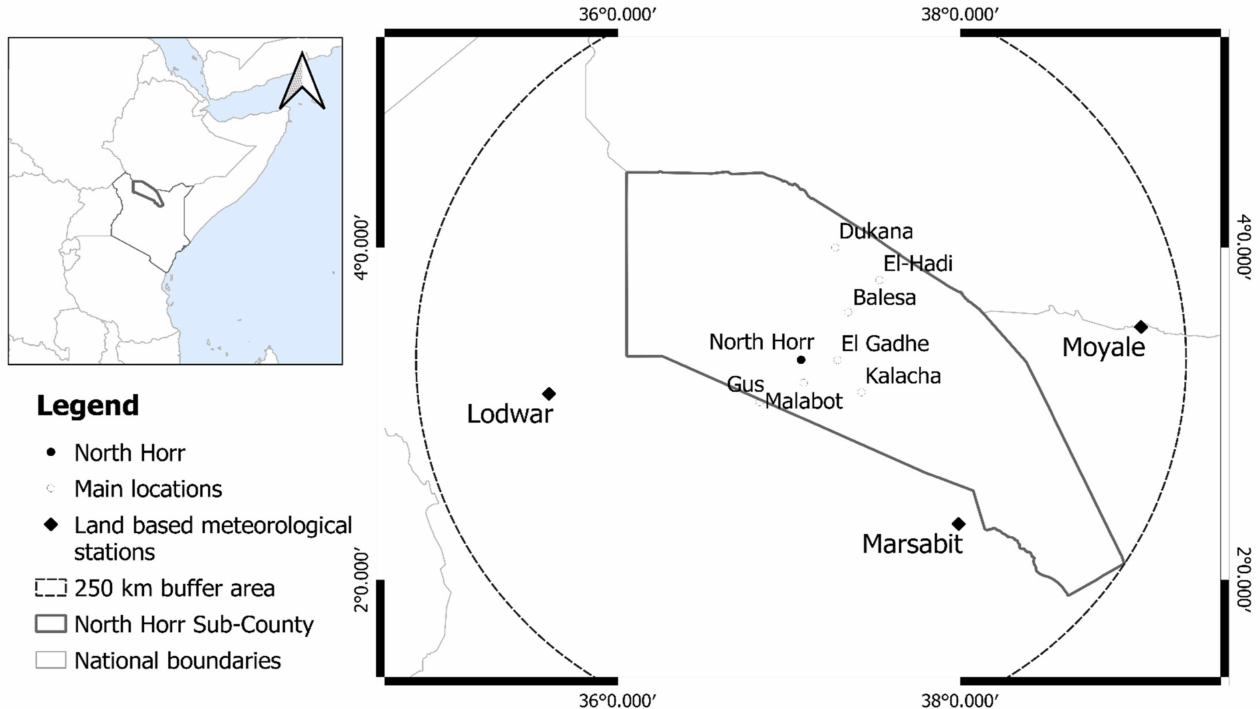
Figure 1. Map of the study area: North Horr Sub-County is highlighted along with the main reference points. Within the 250 km radius from the reference point of North Horr, three land-based meteorological stations are identified (Lodwar, Marsabit and Moyale). Main locations refer to the main inhabited villages located in the study area. Adapted from: